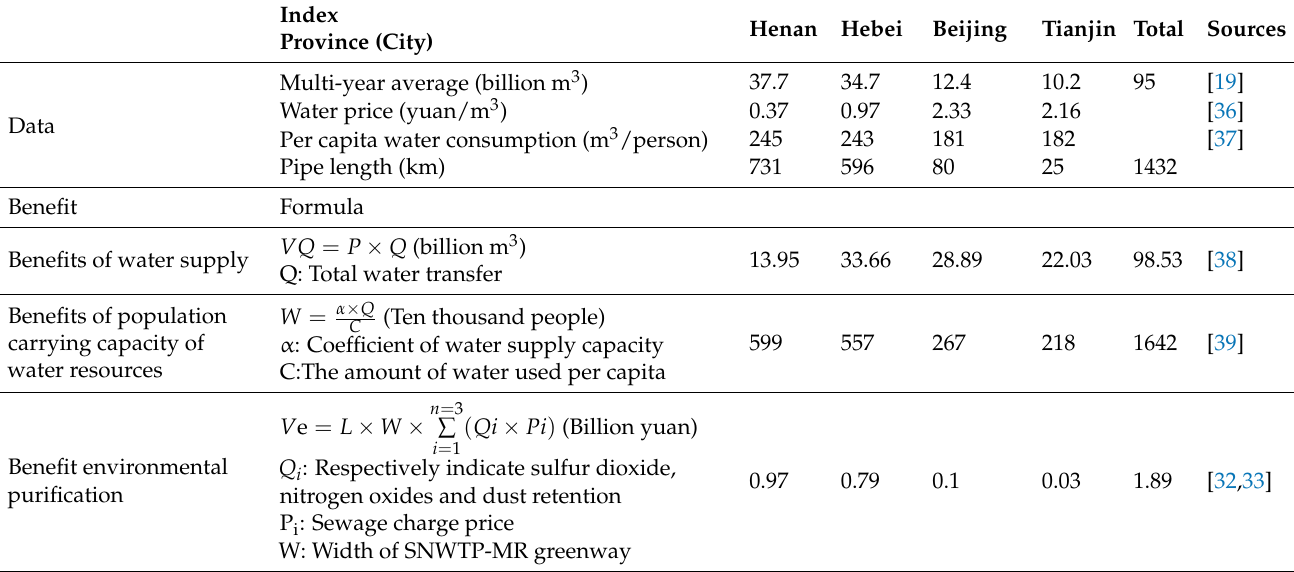
Table 7. Benefits created by SNWTP-MR for water receiving provinces and